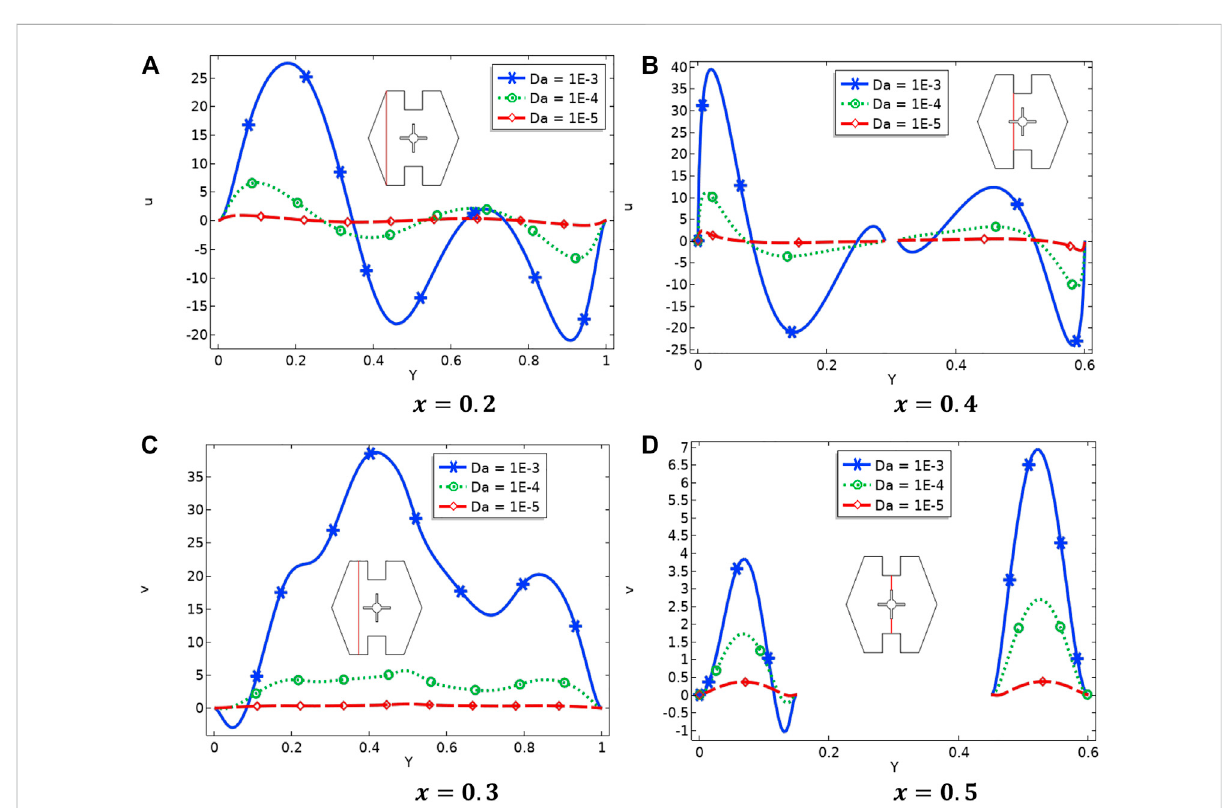
FIGURE 8 (A – F) Variation in velocity and temperature pro fi les at different positions for various Da .